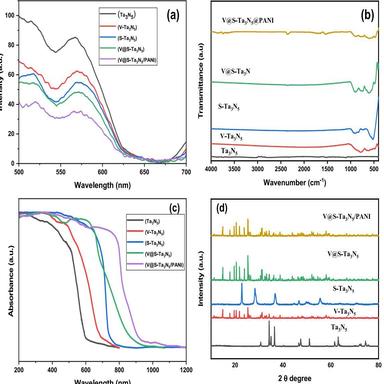
(a) PL spectra of the pristine Ta3N5, V, and S doped- Ta3N5, V@S-codoped Ta3N5 and V@S-Ta3N5/PANI composite materials, (b) FTIR spectrum of the synthesized materials, (c) UV–vis absorption spectra of the pristine Ta3N5, V, and S doped- Ta3N5, V@S-codoped Ta3N5 and V@S-Ta3N5/PANI composite materials, and (d) XRD pattern of Ta3N5 and the synthesized V, and S doped- Ta3N5, V@S-codoped Ta3N5 and V@S-Ta3N5/PANI.